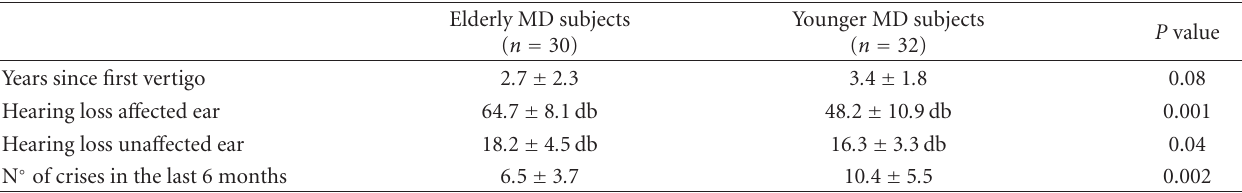
Table 2: Values of hearing loss in a ff ected and una ff ected ear (mean value of frequencies between 250 and 2000 hz), number of vertigo spells in the last 6 months, and years since the first attack in the group of 30 elderly subjects and in the subgroup of 32 patients with a lower of 6 years history of